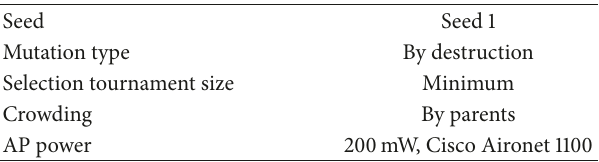
Table 2: Parameter settings for SSGA.